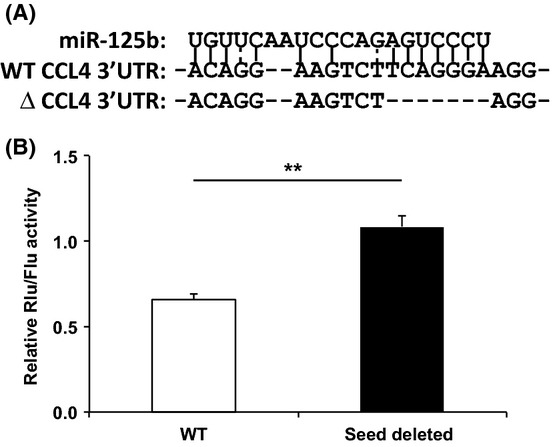
Inhibition of CCL4 expression by miR-125b through a binding site at the 3′UTR of CCL4. (A) The diagram of the putative miR-125b binding site at the 3′UTR of CCL4 and miR-125b binding site deleted mutant. The complementary base pairing between CCL4 3′UTR and miR-125b is predicted by ‘MicroRNA.org’. (B) Inhibition of CCL4 by miR-125b requiring the specific sequence at the 3′UTR of CCL4. miR-125b overexpressed Jurkat cells were further transfected with a renilla luciferase reporter containing either wild-type 3′UTR or miR-125b binding site deleted 3′UTR of CCL4. The renilla luciferase activity was normalized to the constitutively expressed firefly luciferases. The data are presented as the means of three independent experiments and SEM (N = 9, **P < 0.01).